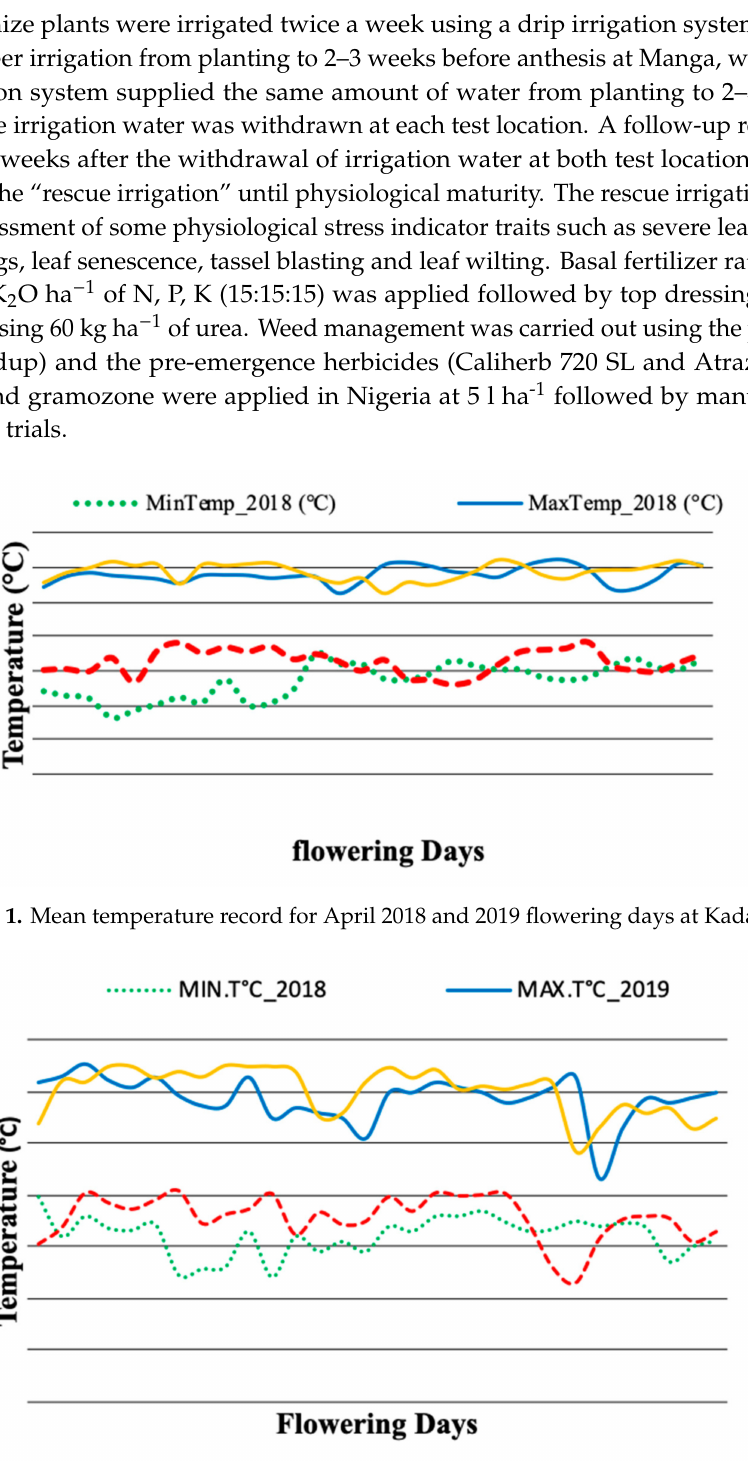
Figure 2. Mean temperature record for April 2018 and 2019 flowering days at